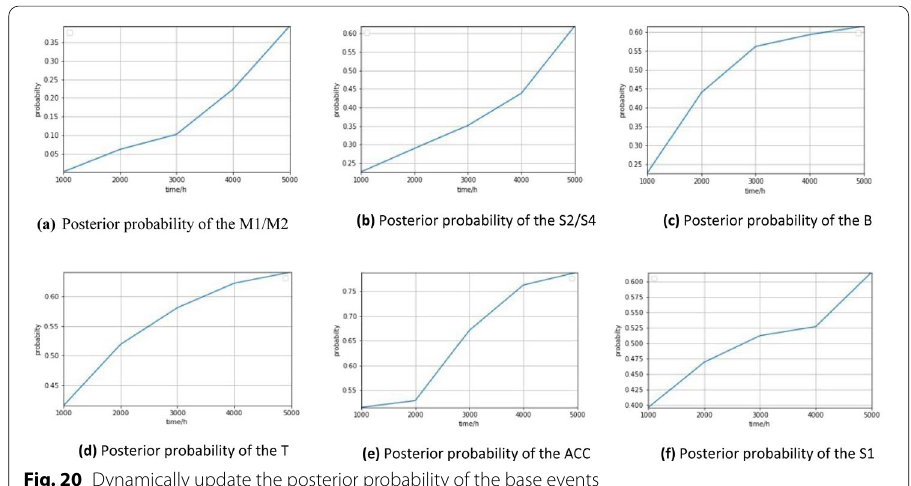
Fig. 20 Dynamically update the posterior probability of the base